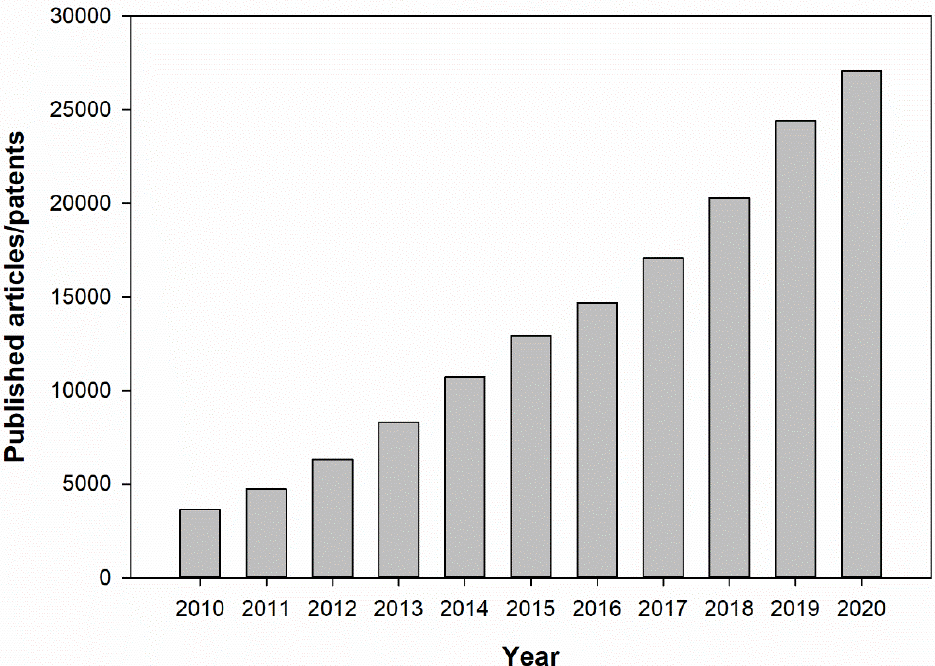
Figure 1. Published articles/patents related to MOs and their composites for LIB applications. Data collected from Google Scholar (https://scholar.google.com) (accessed on 15 June 2021) database with keyword: “Metal oxide lithium-ion batteries”.